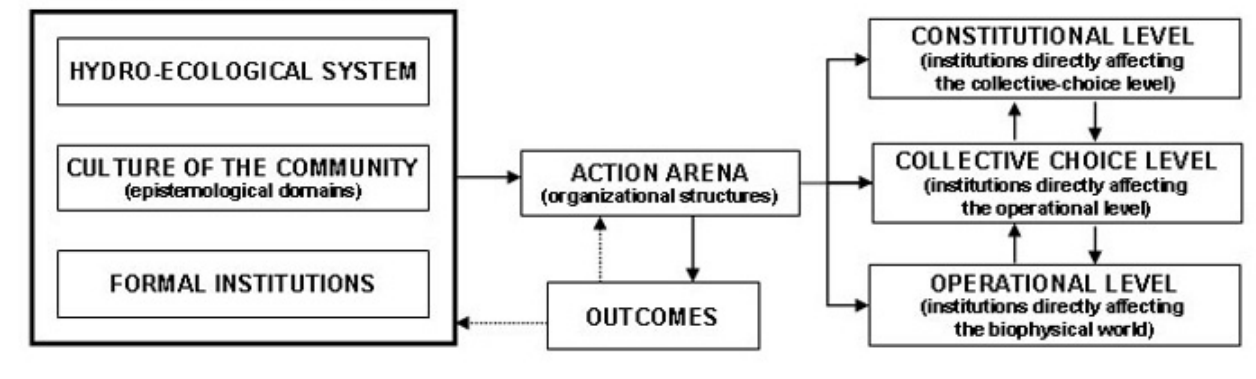
Fig. 1 . The Institutional Analysis and Development framework, applied to the Doñana water socio-ecosystem (adapted from Ostrom et al. 1994 with permission from The University of Michigan Press, Ann Arbor, Michigan,